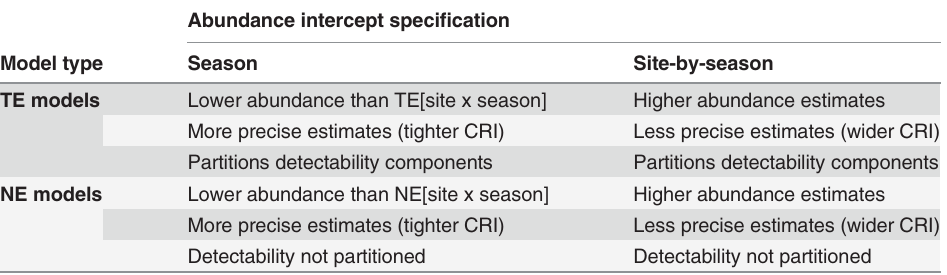
Table 3. Summary of differences between temporary emigration (TE) models and standard binomial mixture (NE) models with either season-speci fi c or site-by-season abundance